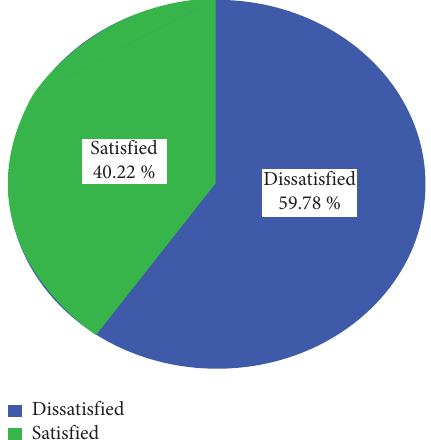
Figure 1: Level of patient satisfaction toward quality of care at Gambella General Hospital, Southwest Ethiopia, 2020. Table 3: Multivariable logistic regression analysis for factors associated with the patient satisfaction toward quality of care, in wards of Gambella Hospital, Southwest Ethiopia, 2020 ( n �